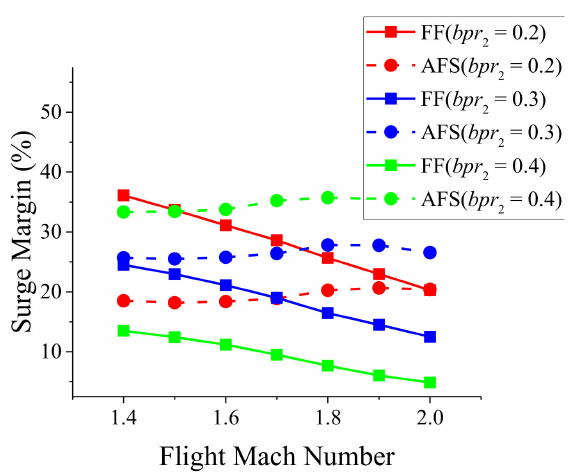
Figure 16. The Variations of Surge Margins of Front Fan and AFS at the conditions of Different Second Bypass Ratios ( bpr 2